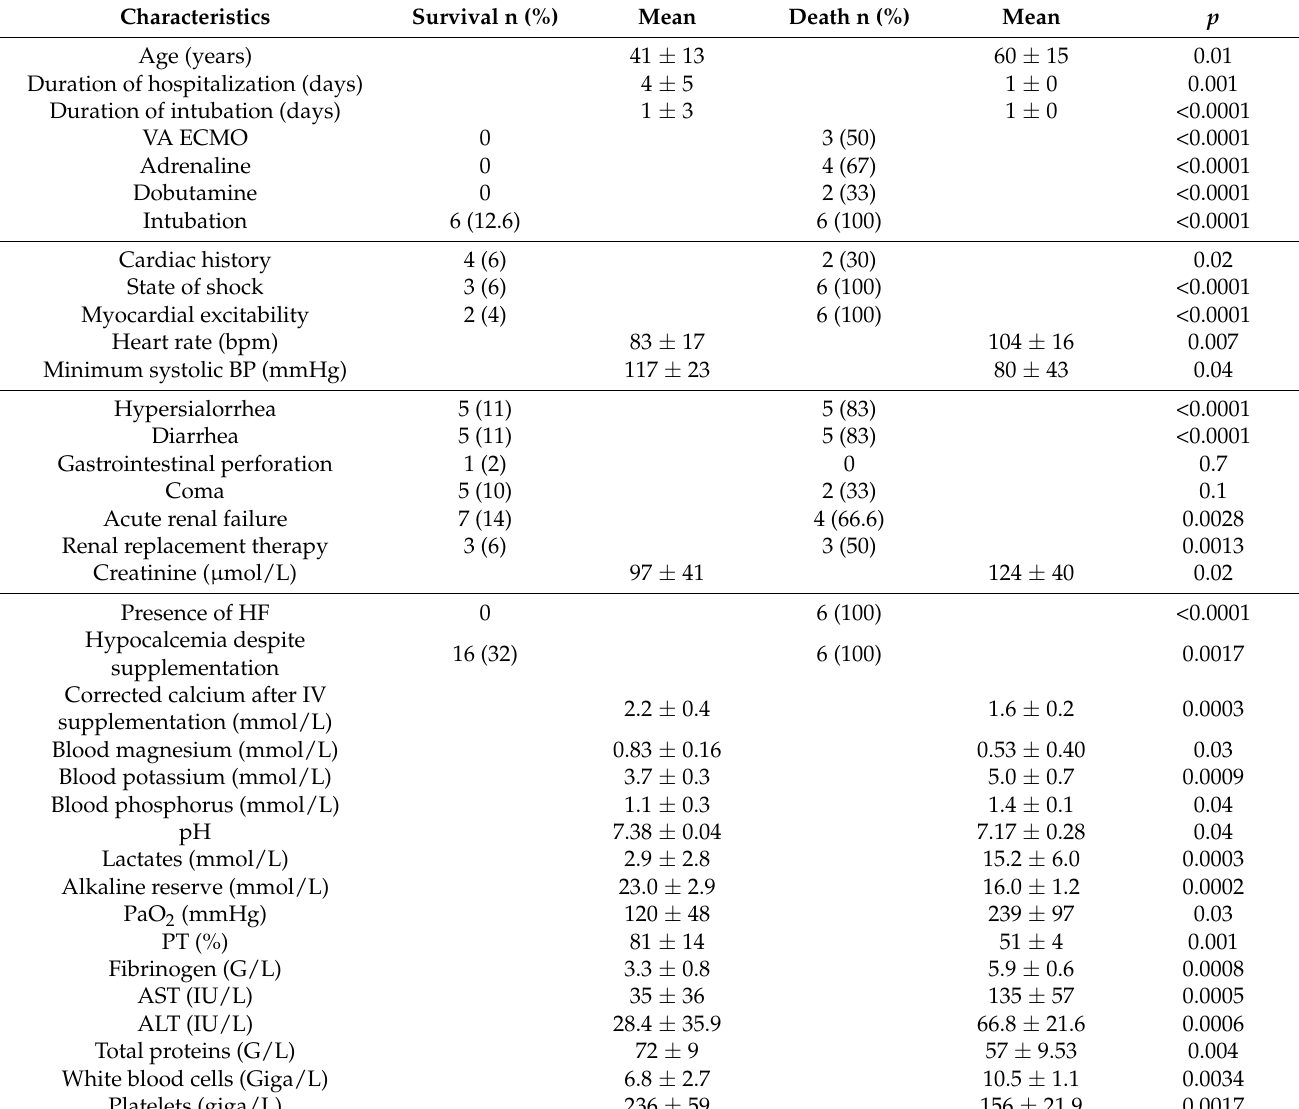
Table 2. Univariate analysis of relationship between clinical-biological characteristics and occurrence of